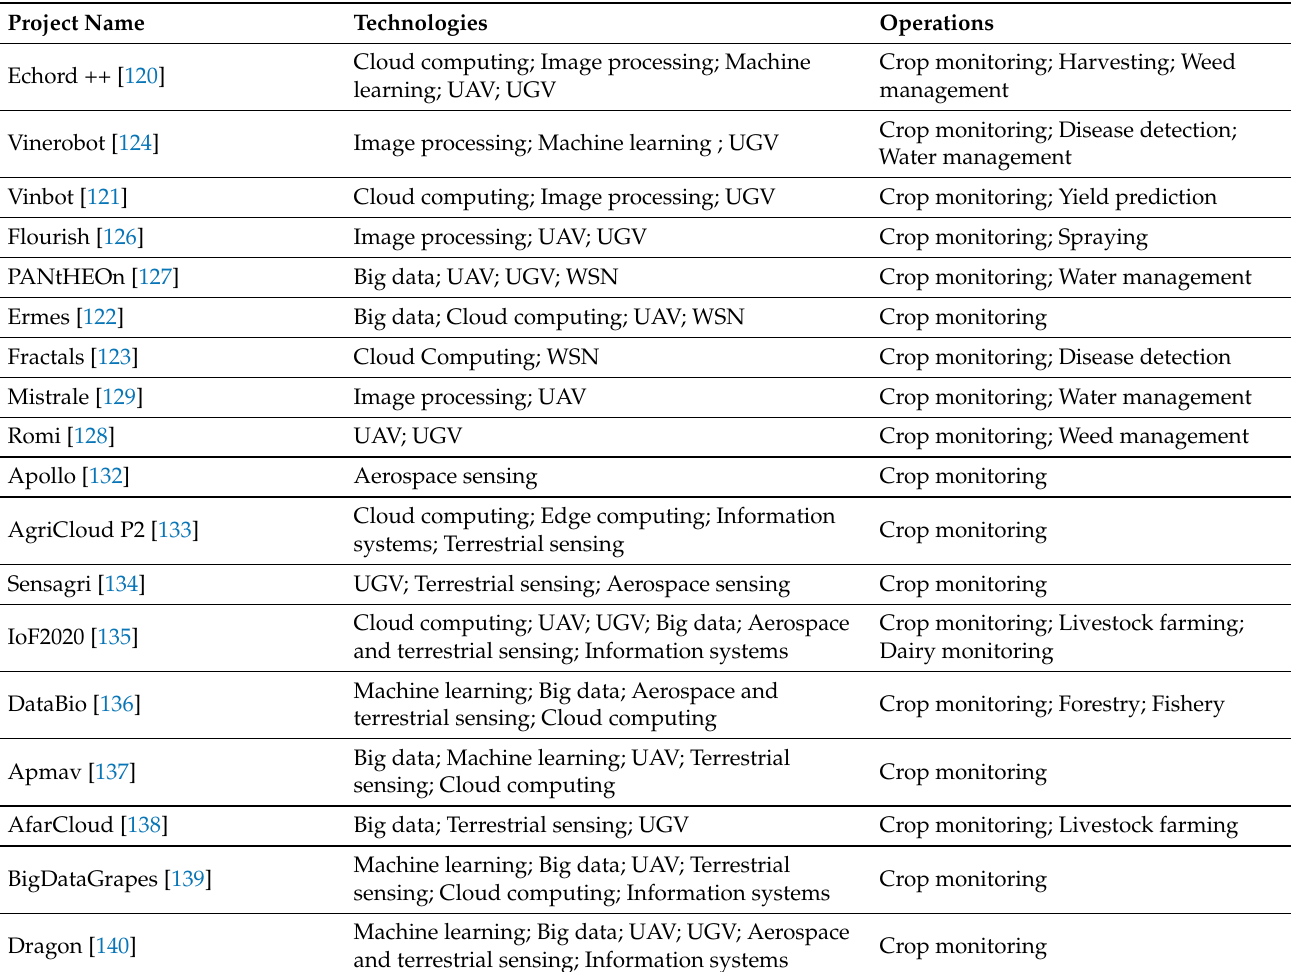
Table 4. Smart Farming projects in EU for crop